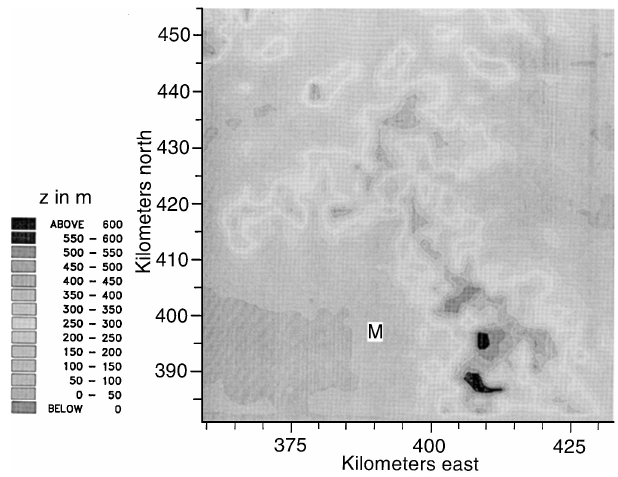
Fig. 2. Topography of the innermost domain at a resolution of 2 (cid:93) 2 km (cid:50) . The axes use standard national UK grid references p is atmospheric pressure, g is the gravitational constant, (cid:72) is the potential temperature, and (cid:115) (cid:105)(cid:106) is the stress tensor due to the subgrid-scale turbulent